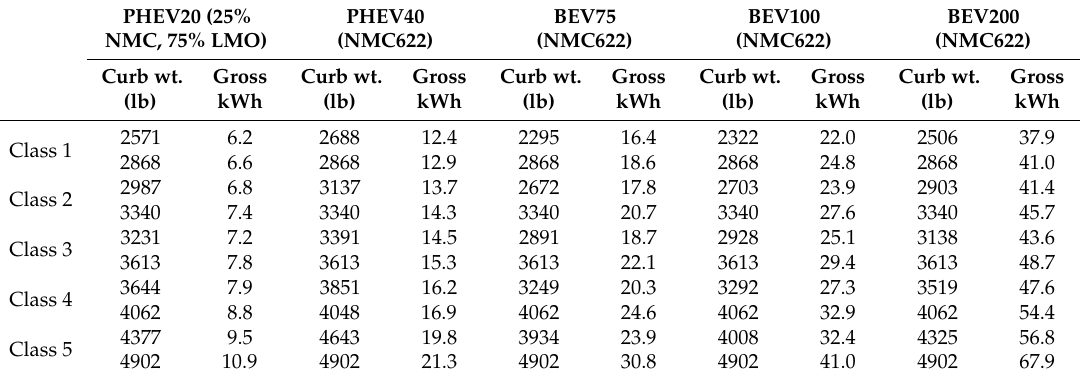
Table 1. Projected gross battery capacity for MY 2025 by vehicle type, power-to-weight class, and